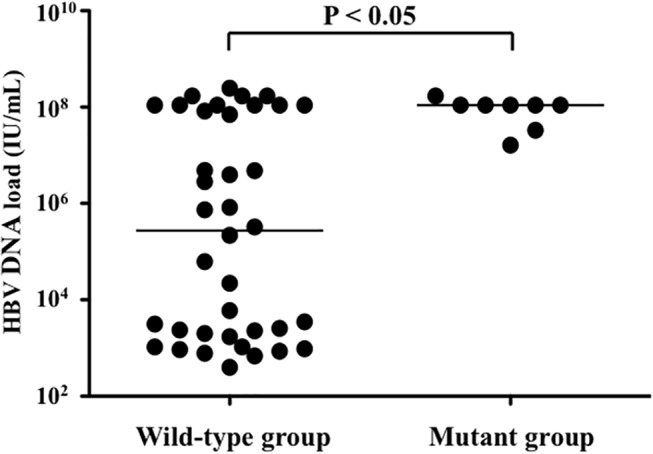
Correlation between baseline HBV DNA loads and emergence of 3TC-resistance mutations.Each dot represents the HBV DNA load of a clinical sample at baseline. The horizontal lines indicate the median values of HBV DNA loads: 2.7 × 105 IU/mL in the wild-type group, 1.1 × 108 IU/mL in the group in which 3TC-resistance mutations emerged (mutant group).